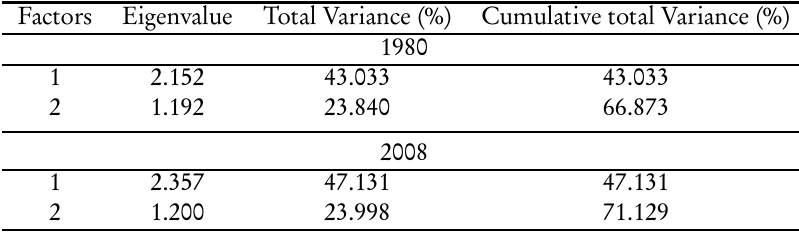
Variability explained by first two principal components in the two years 1980 and